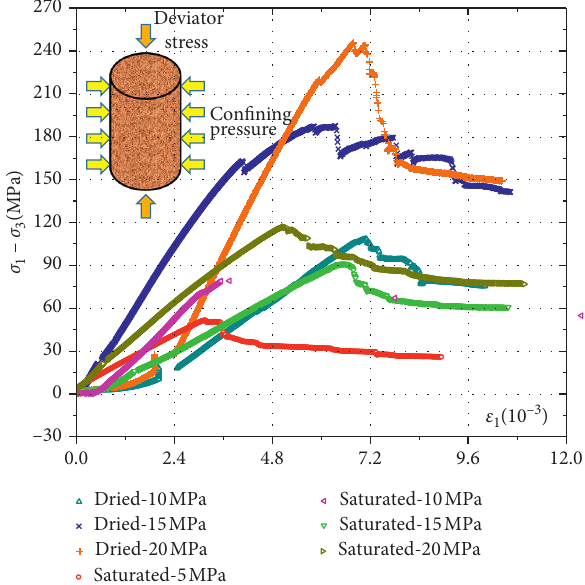
Figure 7: Stress-strain curves for dried and saturated samples in the triaxial test. Note that the stress in the legend is confining pressure.